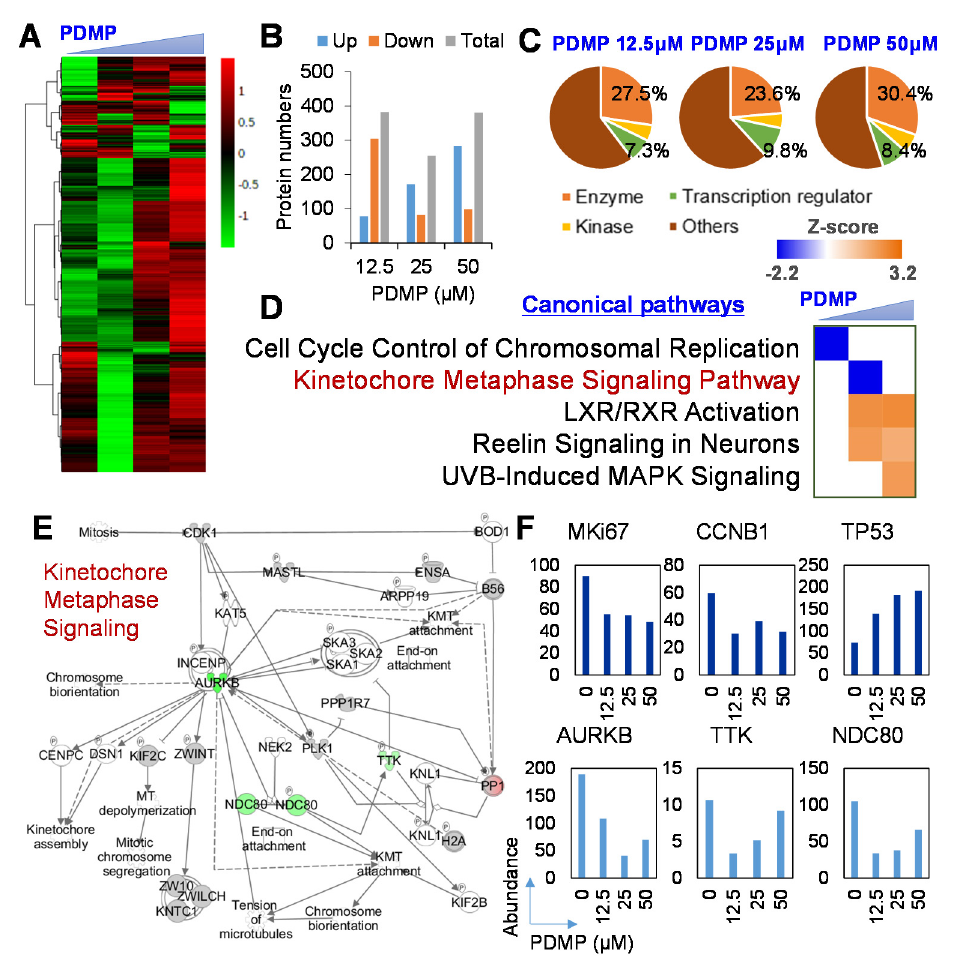
Figure 4. Proteome-based analysis of downstream signaling pathway following ganglioside synthesis inhibition in liver cancer cells. nLC-MS/MS-based proteome analysis was performed in the HCC cell line, JHH7, treated with vehicle control DMSO or ganglioside synthesis inhibitor PDMP at 12.5, 25, and 50 µ M for 24 h. ( A ) Heatmap visualization of a total of 4828 identified proteins. ( B ) Summary of the number and ( C ) functional annotation of differentially expressed proteins in JHH7 cells treated with PDMP in comparison with those treated with DMSP with a cut-off of fold change more than 2. ( D ) Canonical pathway analysis of differentially expressed proteins generated using the knowledge-based functional analysis software Ingenuity Pathways Analysis (IPA) with a cut-off of z-score more than 2. ( E ) A representative network related to cell cycle progression entitled “Kinetochore Metaphase Signaling”. Upregulated proteins under the control of PDMP are shown in red, downregulated proteins under the control of PDMP are shown in green, and proteins that were not annotated in this study but were part of this network, are shown in white. ( F ) Expression of enriched proteins involved in the kinetochore metaphase signaling pathway and cell cycle related proteins MKi67, CCNB1, and TP53 detected by nLC-MS/MS.